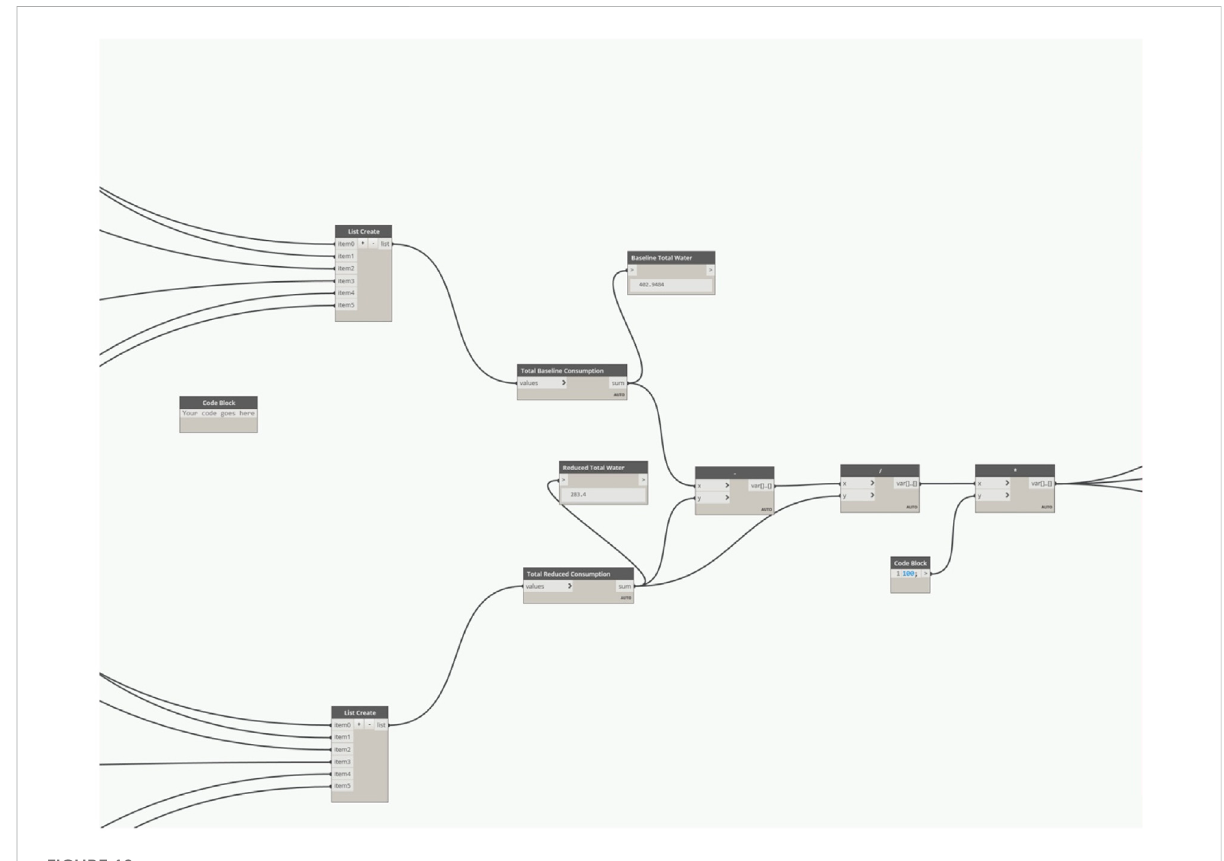
FIGURE 10 Part of dynamo script for Mostadam water